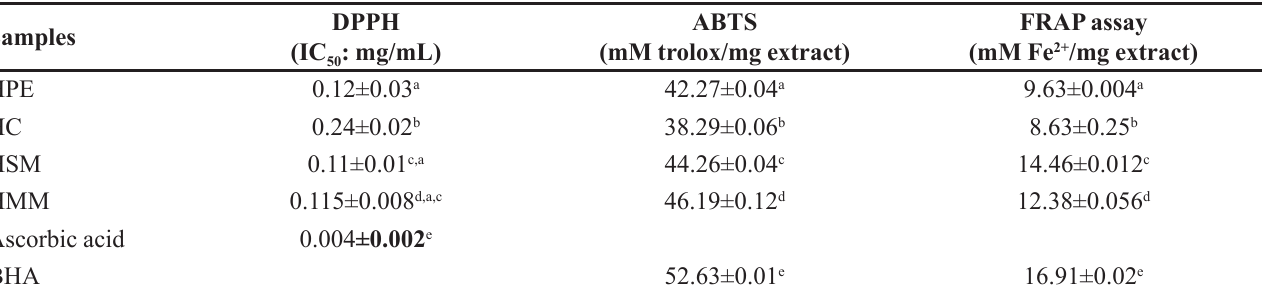
TABLE II - The antioxidant activity of H. plicatum subsp. plicatum extracts Samples